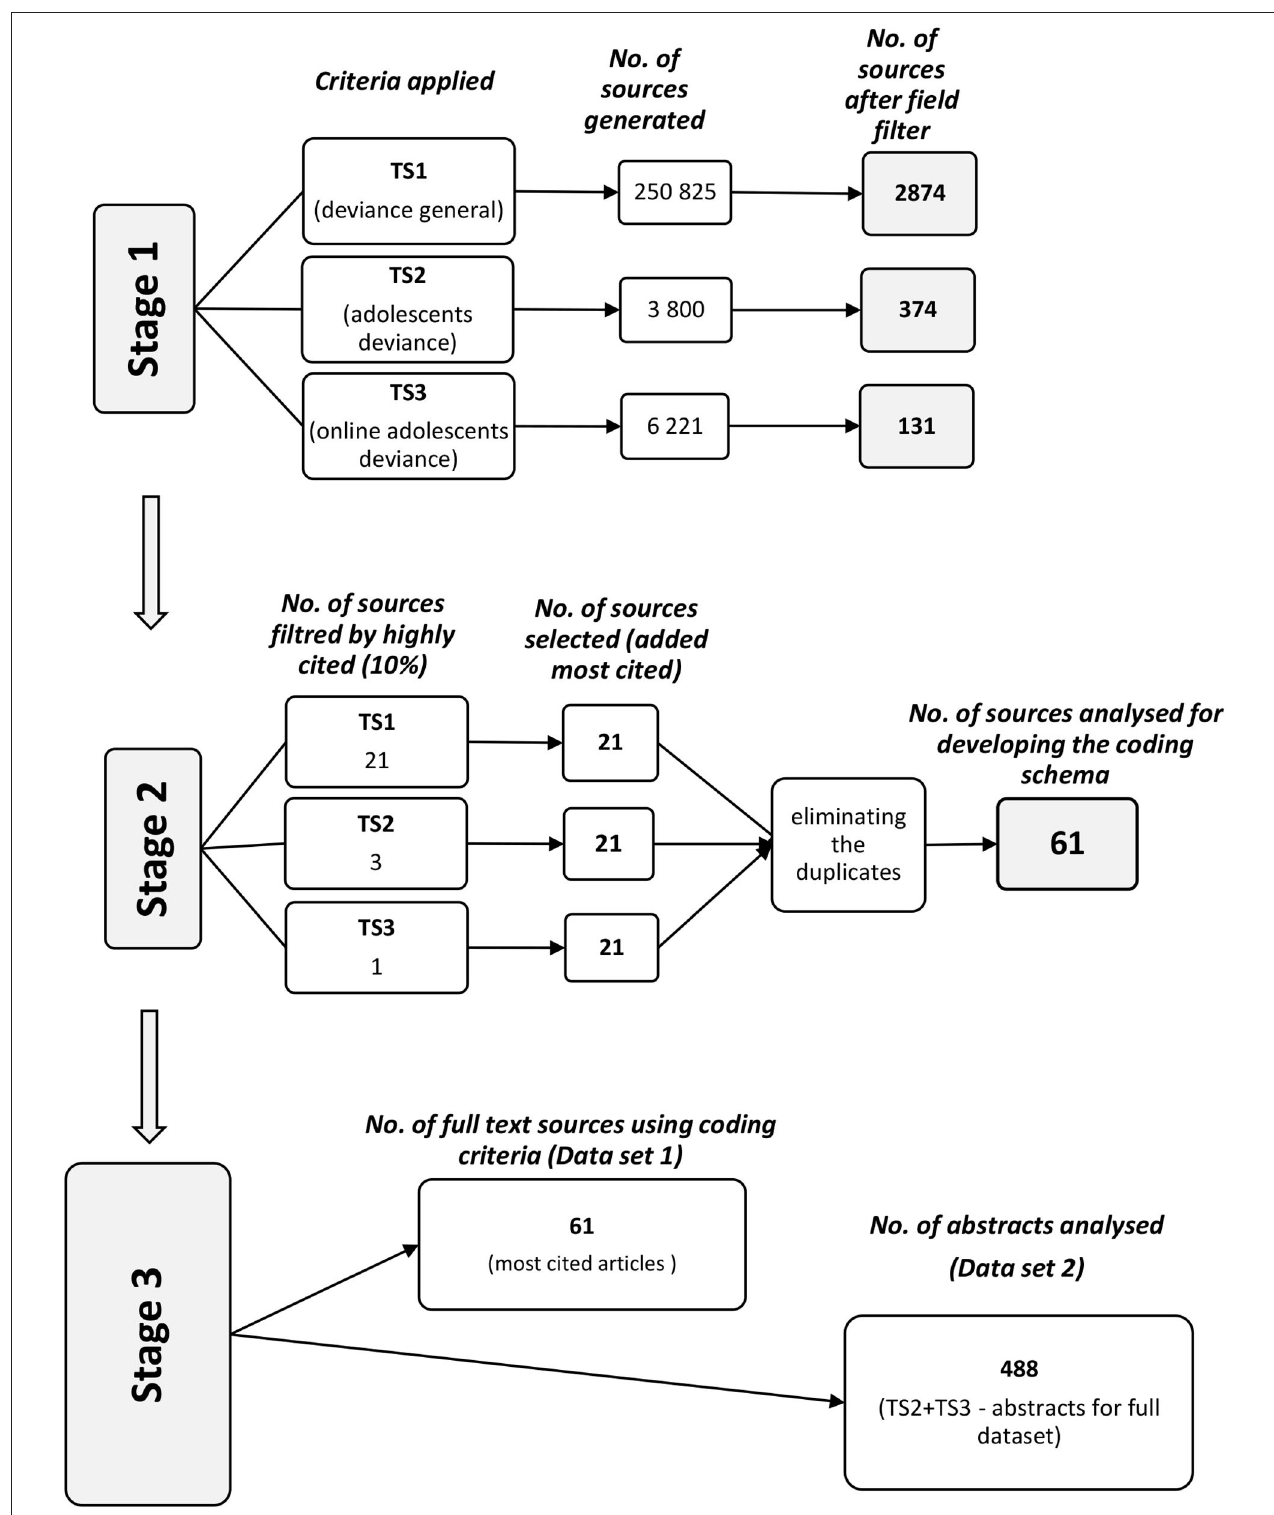
FIGURE 1 | The systematic literature review